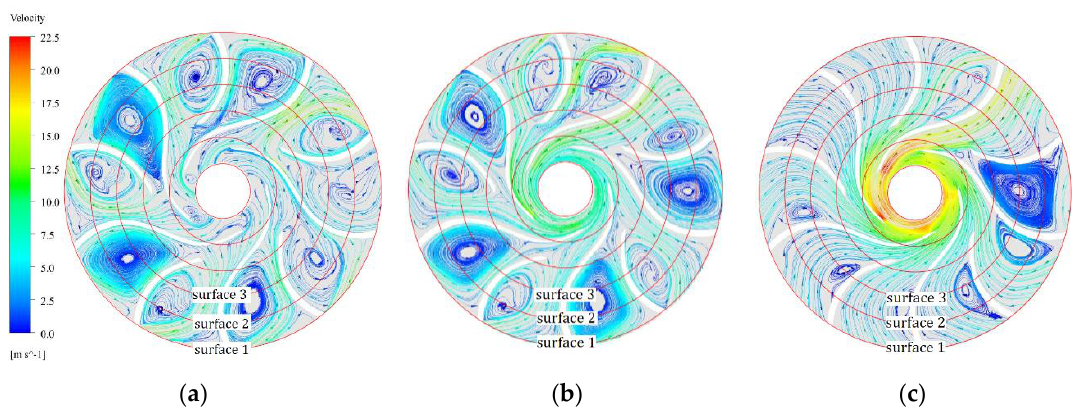
Figure 12. Streamline at radial plane of impeller. ( a ) 0.6 Q d ; ( b ) 1.0 Q d ; ( c ) 1.6 Q d .